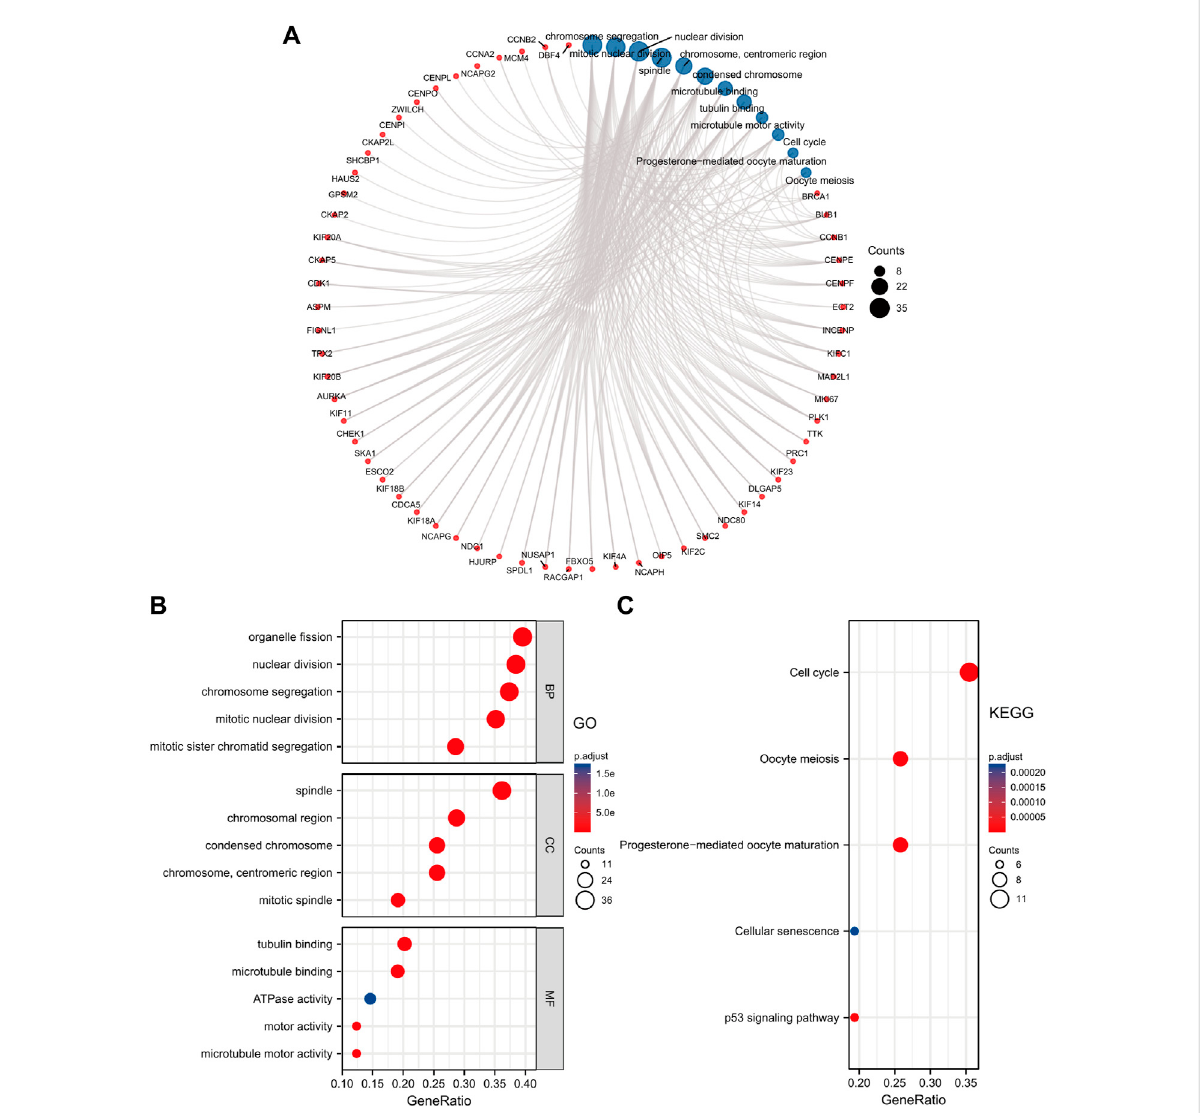
FIGURE 7 GO and KEGG enrichment analysis of ANLN co-expressed genes. (A) Visual network of GO and KEGG analyses. (B) GO analysis shows the top fi veenrichedtermsofBP,CC,andMF. (C) KEGGanalysisshowsthetop fi veenrichedpathways.Thecolorandsizeofthecirclerepresenttheadjusted p -value and counts number,